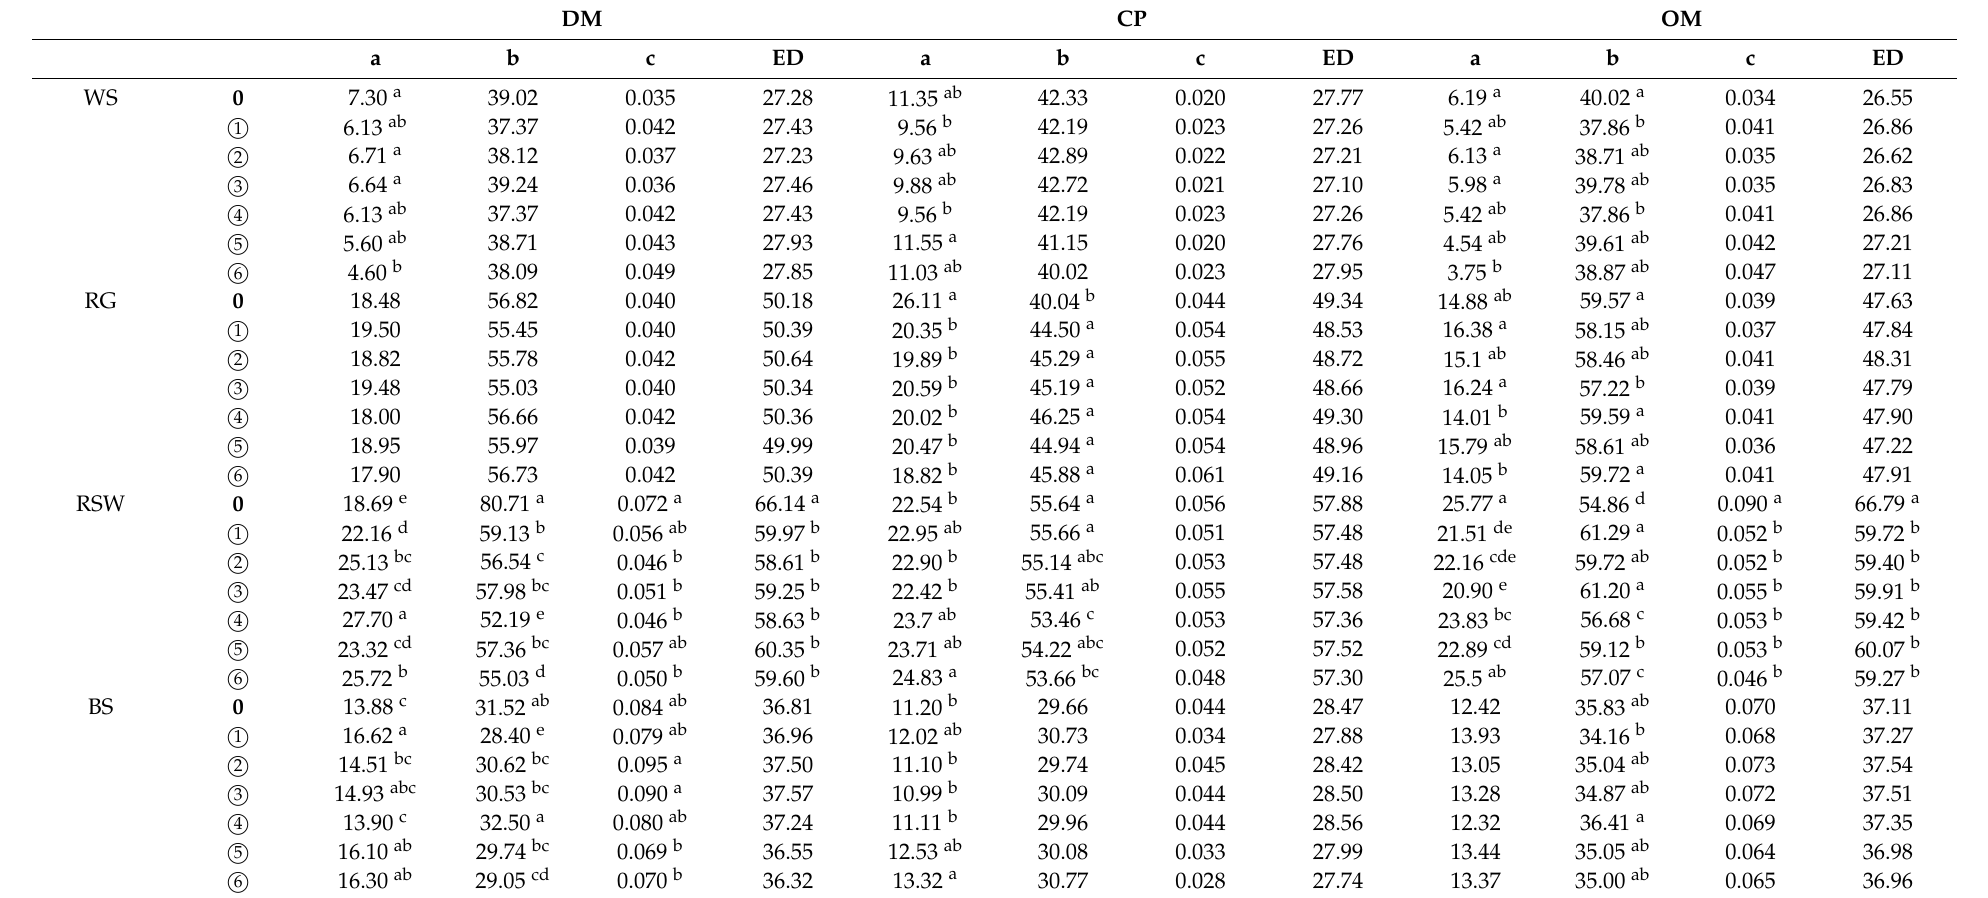
Table 5. The degradation parameters of dry matter, crude protein, and organic matter in rumen of 10 roughages